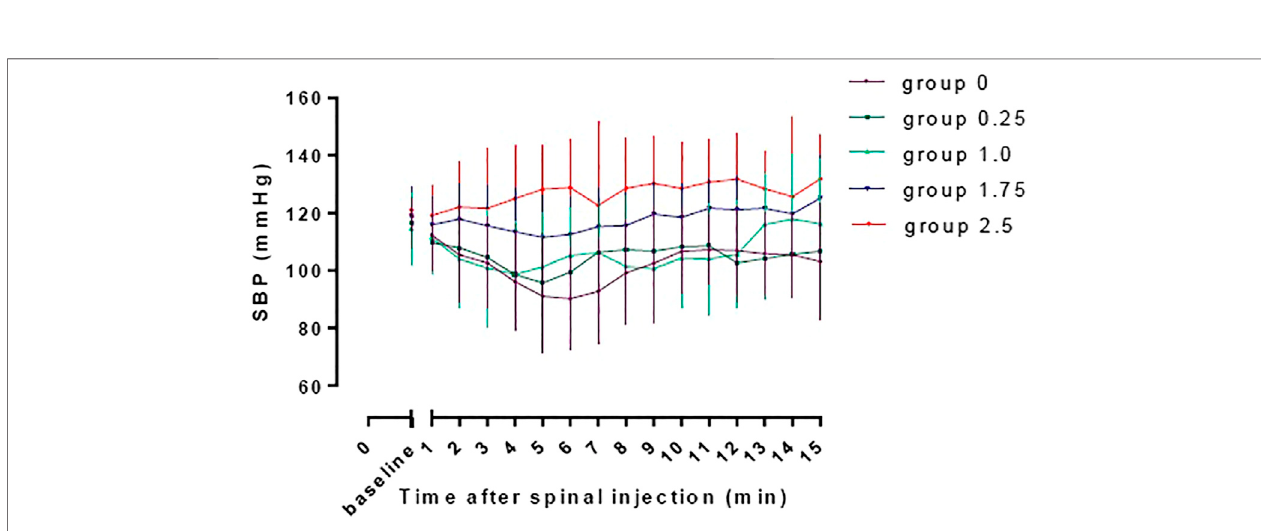
Frontiers in Pharmacology |